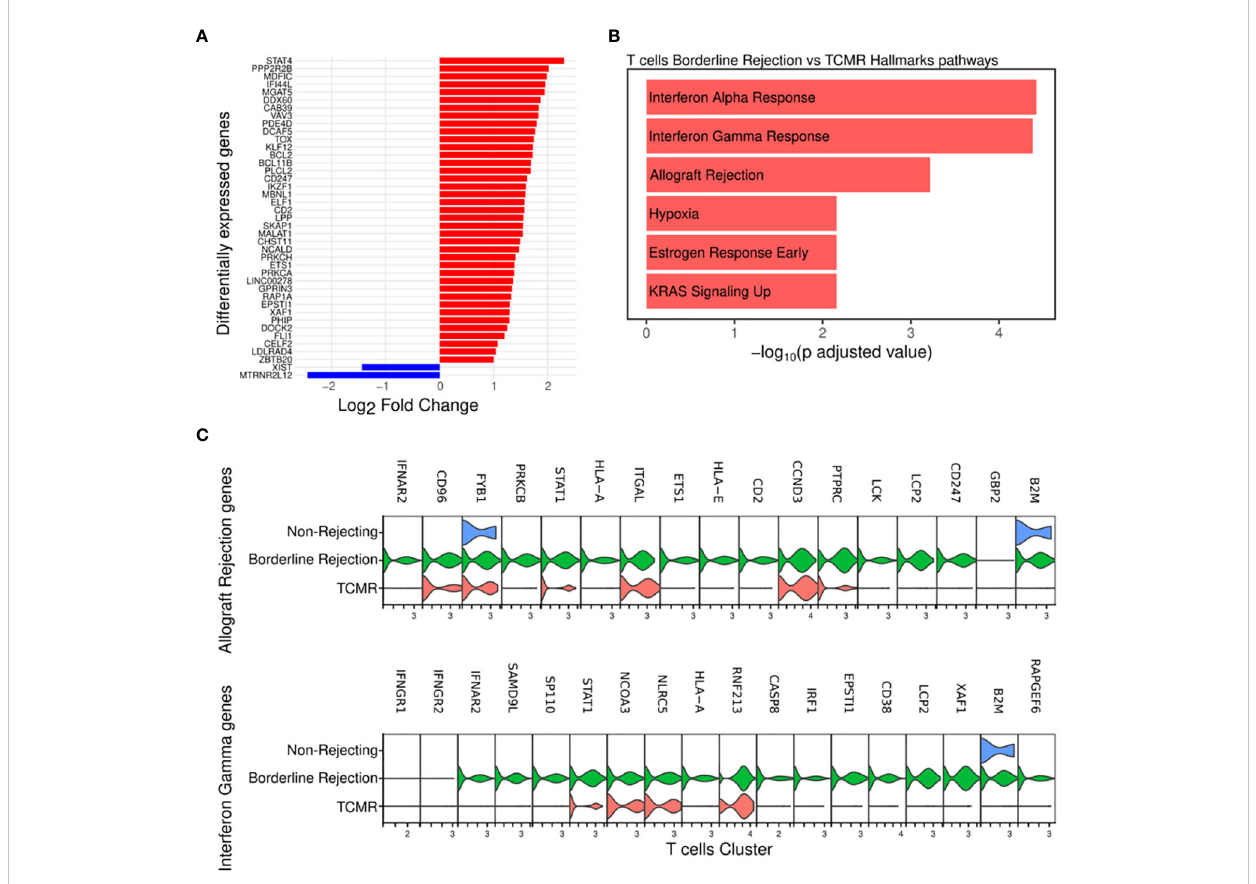
FIGURE 2 (A) Plot showing the differentially expressed genes between borderline (red) and TCMR (blue). (B) Pathway analysis of T-cell cluster in borderline compared to TCMR samples using Hallmark database showed enrichment for interferon-gamma and alpha responses and allograft rejection pathways (C) Violin plots showing the level expression of genes part of allograft rejection and interferon-gamma response pathways in three